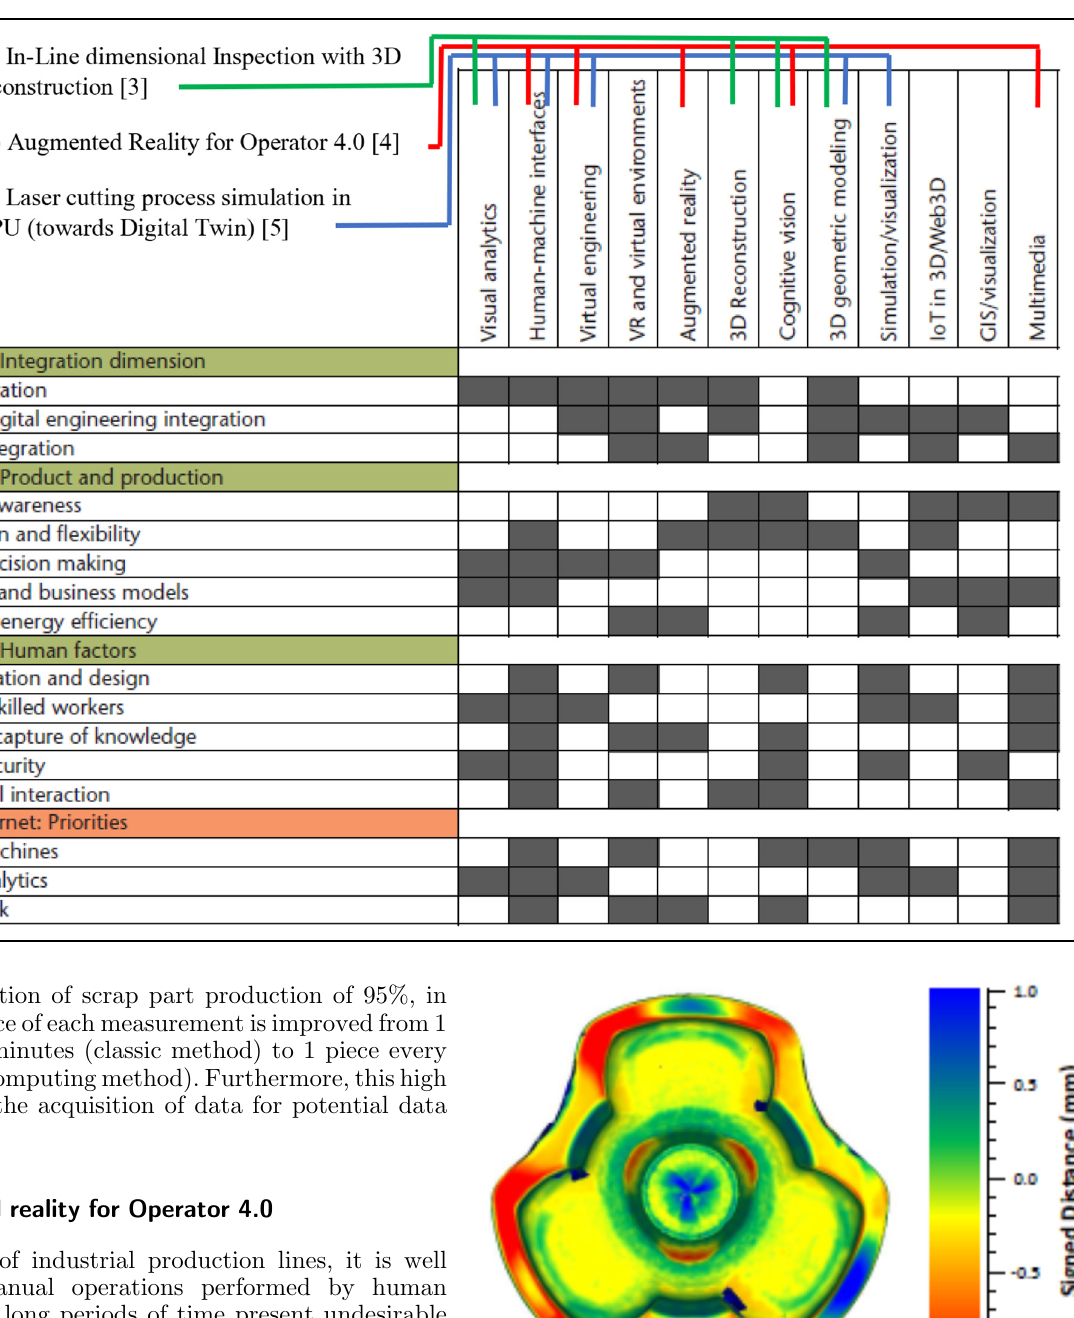
Table 1. Selected examples contextualised in the conceptual framework of Visual Computing for Industry 4.0, according to the methodology introduced by Posada et al. [1].